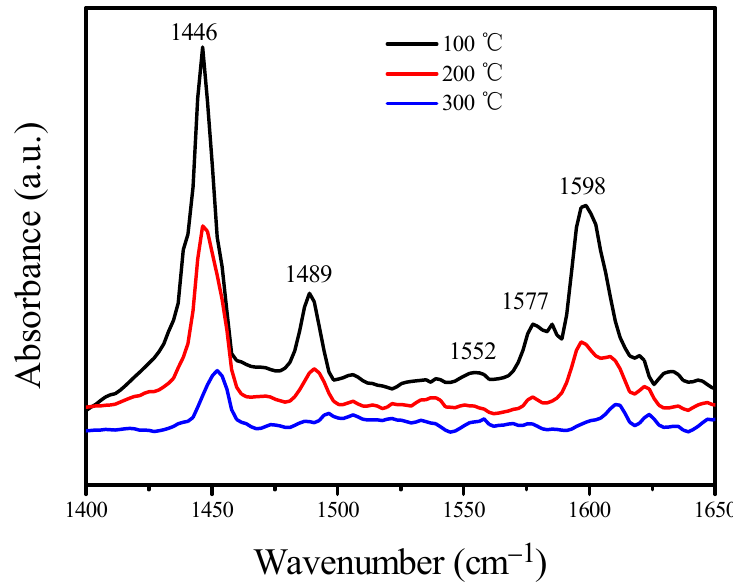
Figure 3. FTIR spectra of the pyridine adsorbed on TNPs-1.